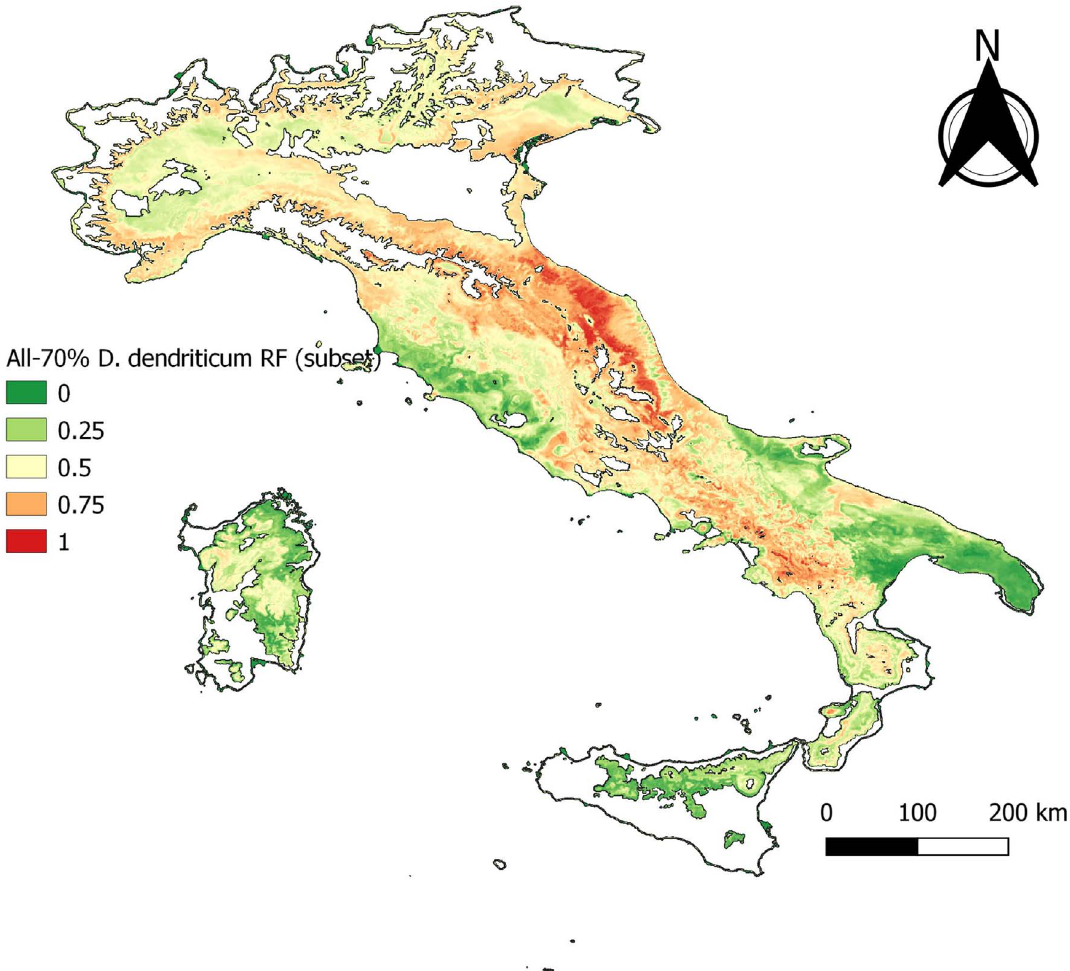
Figure 5. Baseline model, (cid:1)